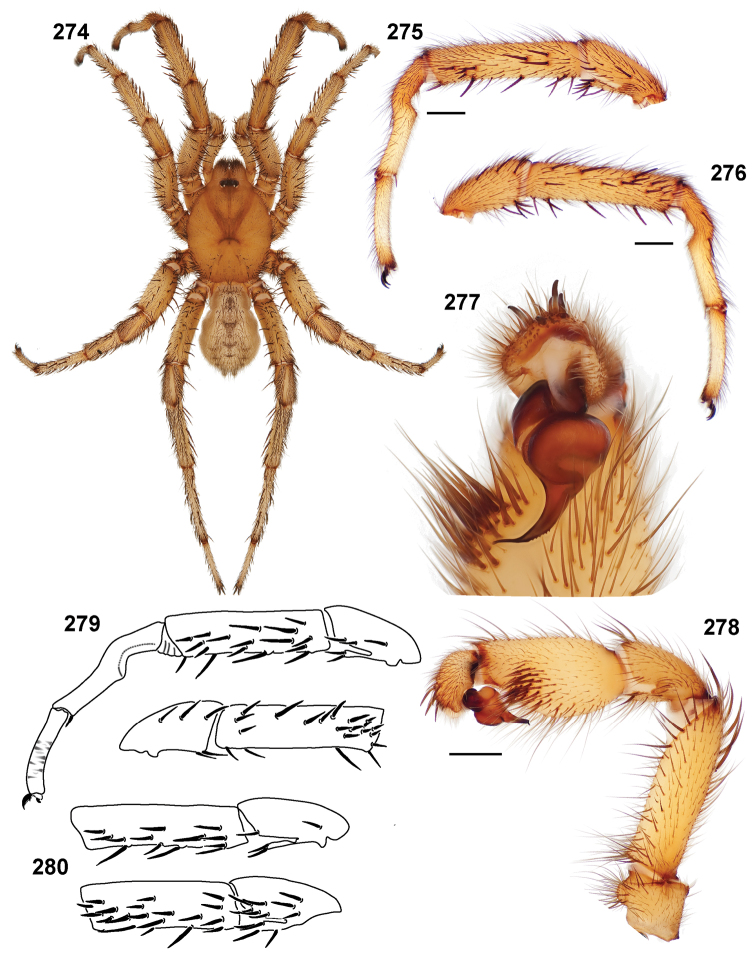
Aptostichus simus Chamberlin, 1917 male specimens from San Diego County; scale bars = 1.0mm. 274 habitus (AP1209) [806521] 275–278 secondary sexual characteristics (AP819) 275 retrolateral aspect, leg I [806525] 276 prolateral aspect, leg I [806529] 277 ventral view, pedipalp bulb [806531] 278 retrolateral aspect, pedipalp [806533] 279, 280 line drawings, leg I articles 279 retrolateral and prolateral aspect of specimen from San Diego County, Imperial Beach 280 retrolateral aspect, tibia and patella, in descending from San Diego County, Imperial Beach and Santa Barbara County, Carpinteria State Beach.